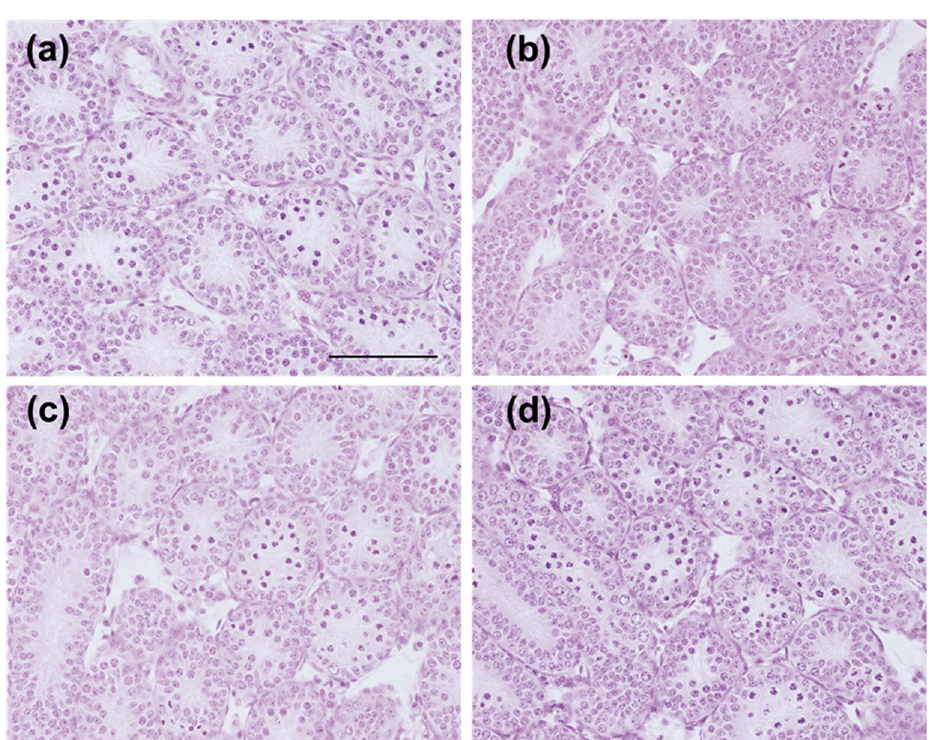
Figure 3. Testicular histology of CORT-administered mice on PND 10. Testicular histology of control ( a ), low-dosed ( b ), middle-dosed ( c ), and high-dosed-CORT mice ( d ) on PND 10. Representative hematoxylin and eosin (H&E)-stained micrographs are provided. A decrease in the diameter of seminiferous tubules and the height of the seminiferous epithelia were noted in the low- and high-dosed-CORT mice compared to the control. The scale bar is 100 µm.